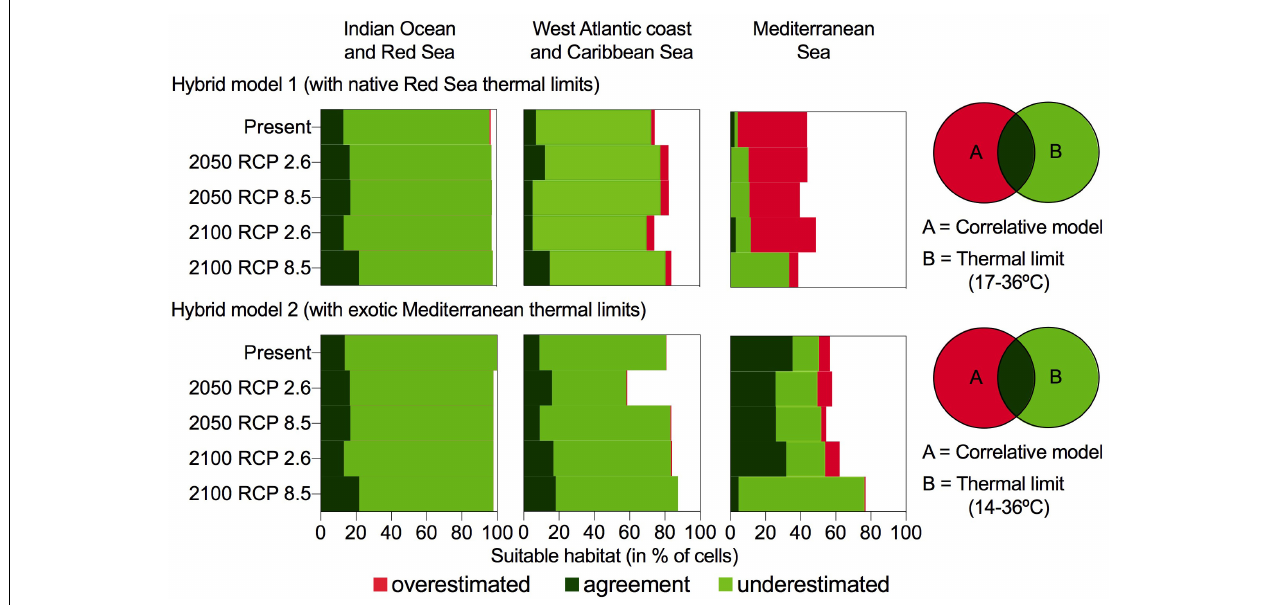
FIGURE 3 | Cumulative barplots with the suitable habitat (in% of cells) for H. stipulacea according to hybrid model 1 (based on native Red Sea thermal limits; 17–36 ◦ C) and the hybrid model 2 (based on exotic Mediterranean thermal limits; 14–36 ◦ C) under present conditions and 4 different climate change scenarios. The hybrid models were obtained by combining the correlative SDMs (realized niche; A ) and the species physiological growth limits (fundamental niche; B ). Dark green bars represent the agreement region, light green bars the underestimated region and red bars the overestimated region of the correlative model in relation to the thermal limits of